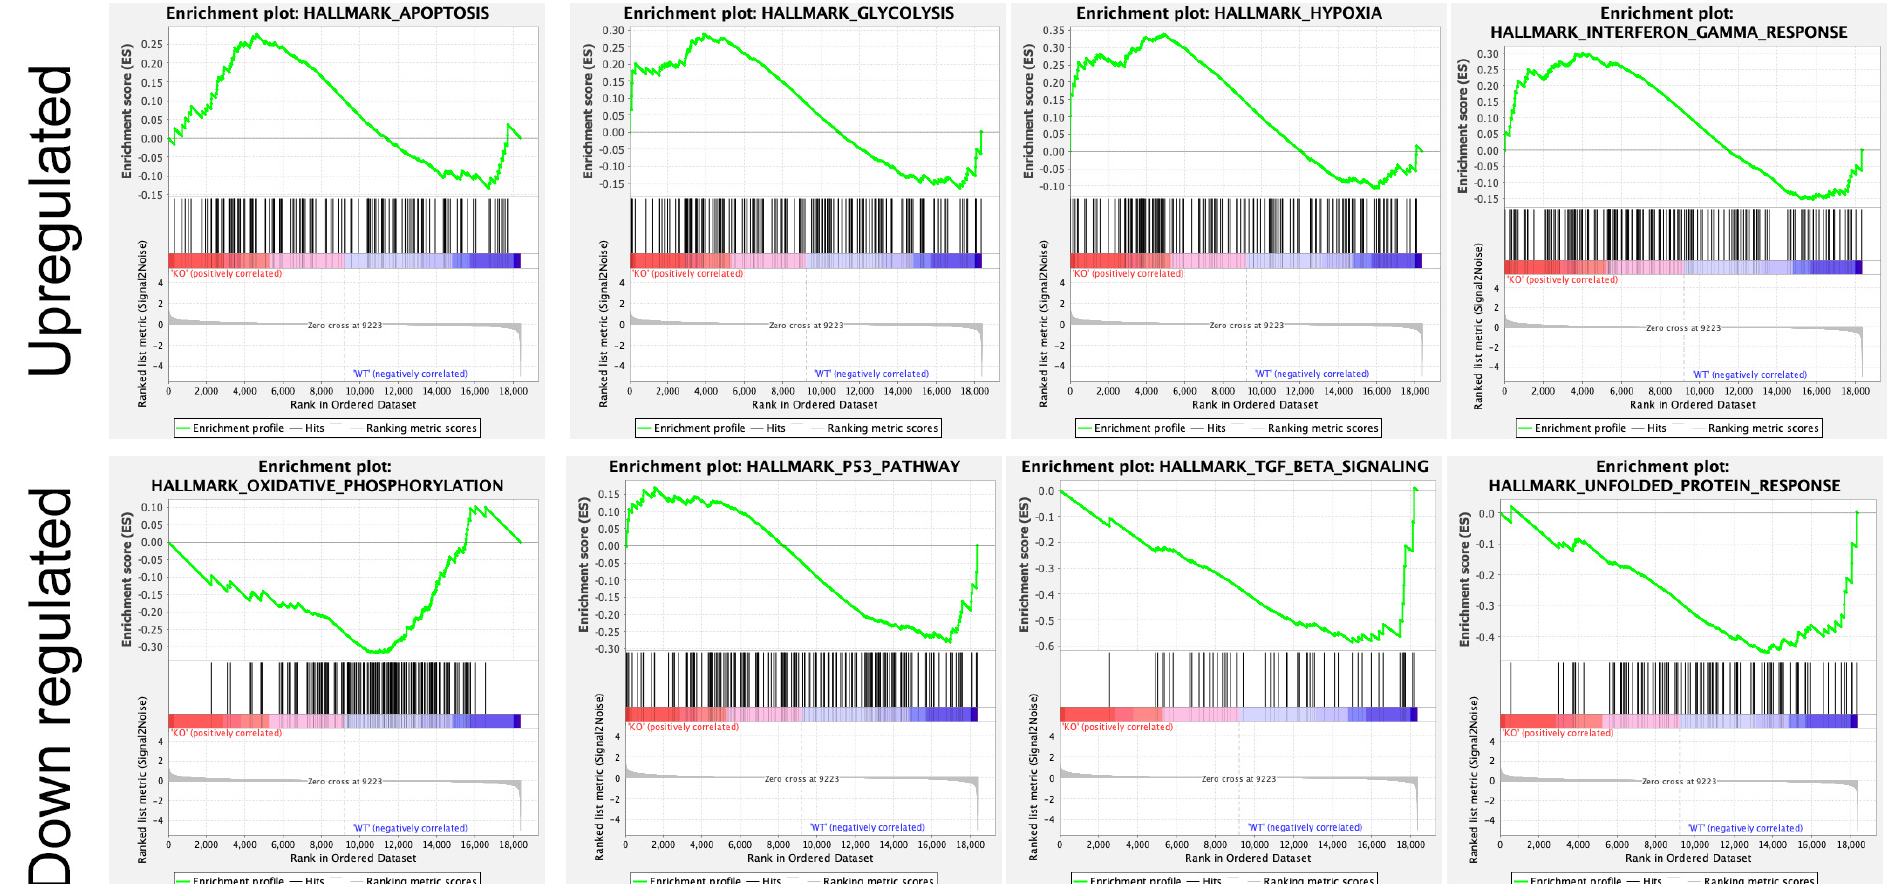
Figure 3. Enrichment plot of top four GSEA hallmarks enriched in Rubcn knockout and wildtype. Rubcn KO group enriched with significant upregulation in apoptosis, glycolysis, hypoxia, and interferon gamma response gene sets (upper panel). Oxidative phosphorylation, p53, TGF β signaling, and unfolded protein response enriched in WT group (lower panel).